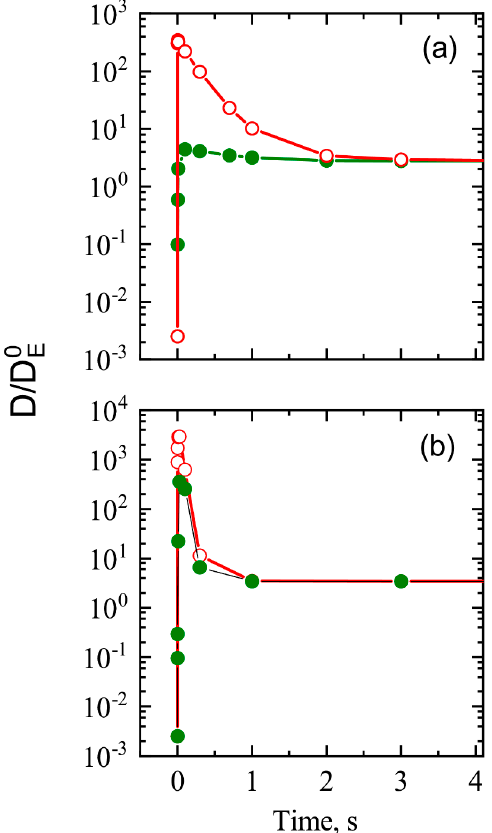
Figure 10. Dynamics of diffusivity factor calculated at 1200 K for the heterostructure with a QW at the spatial position near the heterointerface (opened red circles) and at spatial position shifted from heterointerface in 30 lattice constants (filled olive circles). ( a ) The case of interstitial atom diffusion is close to that for vacancies. ( b ) The case of interstitial atom diffusion is much faster than that of vacancies. The diffusivity factor is normalized to its value , determined by the equilibrium concentration of neutral vacancies.